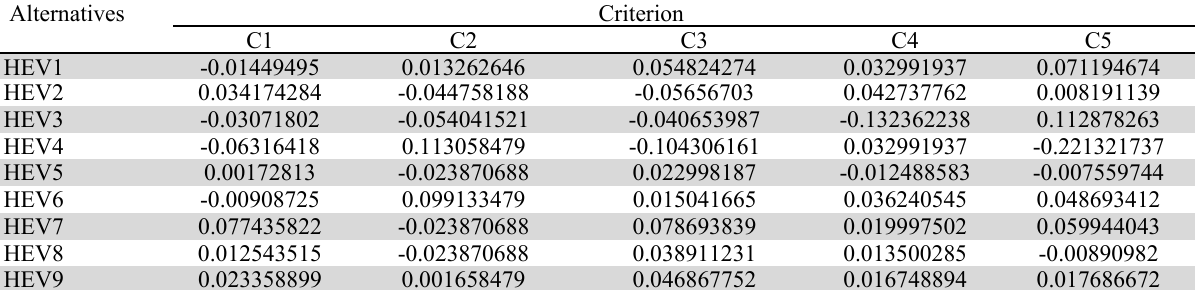
Distance of the alternative from the BAA matrix (Q) Alternatives Criterion